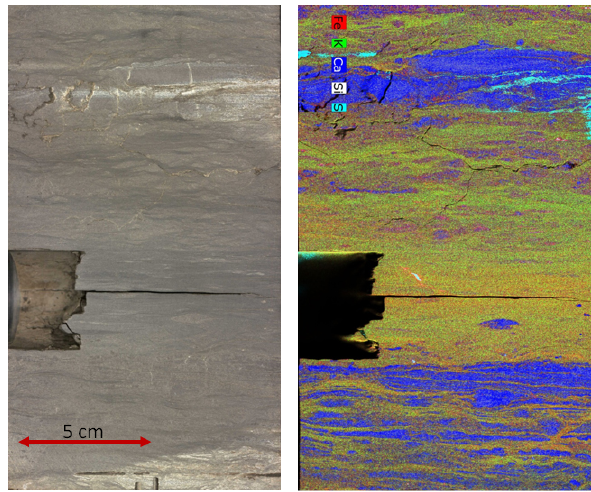
Figure 4. Results of the 2-D mineralogical mapping on the large core sample